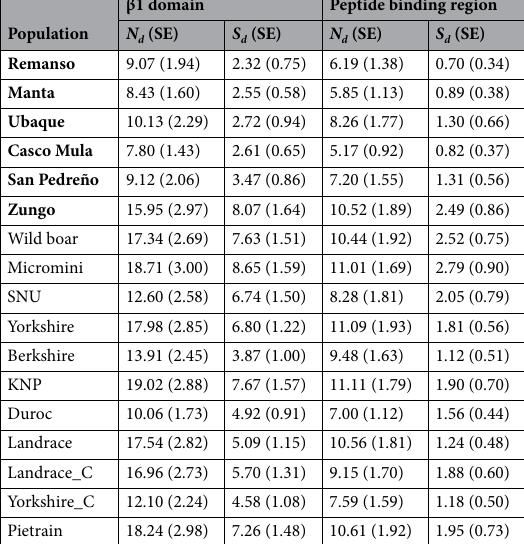
Table 3. The amount of nonsynonymous ( N d ) and synonymous ( S d ) polymorphisms in the sequence encoding the whole β1 domain and peptide binding region (PBR) for the swine populations analysed here. SE standard